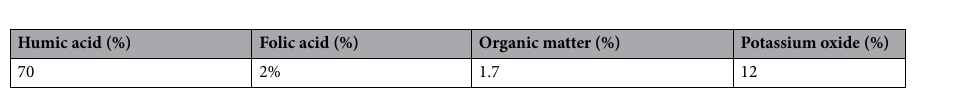
Table 8. The chemical properties of fertilizers used in the present experiment.